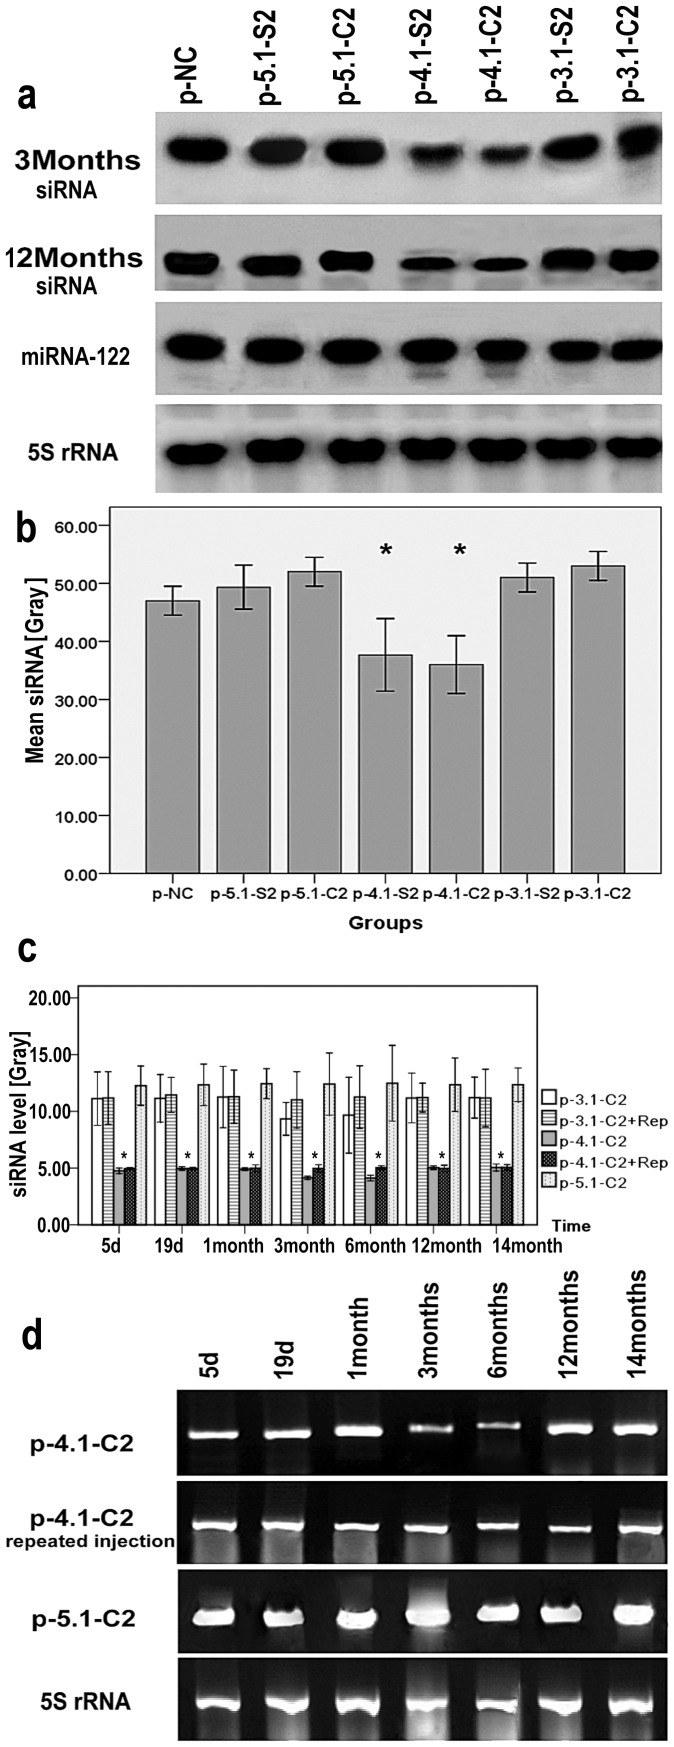
Specific expression of siRNA in the liver of transgenic mice.The HBV-C2 siRNA and HBV-S2 siRNA produced by different vectors were detected by northern blot at 3 and 12 months post-transfection (a). The gray scale analysis chart showed the relative siRNA levels of different vectors at 12 months post-transfection (b). The negative-control plasmid (p-NC) which has a mismatched sequence served as control groups in vitro. The siRNAs were quantitated by qRT-PCR after both single and repeated injection with vectors (c). The HBV-specific siRNAs in the liver were measured by qRT-PCR in different groups, such as p-4.1-C2, p-4.1-C2 repeated injection, and pSilencer5.1-C2 (p-5.1-C2) (d). Error bars represent standard error (SE) of the mean. Rep., repeated injection; p-, pSilencer-; qRT-PCR, quantitive reverse transcription PCR. (*p<0.05).